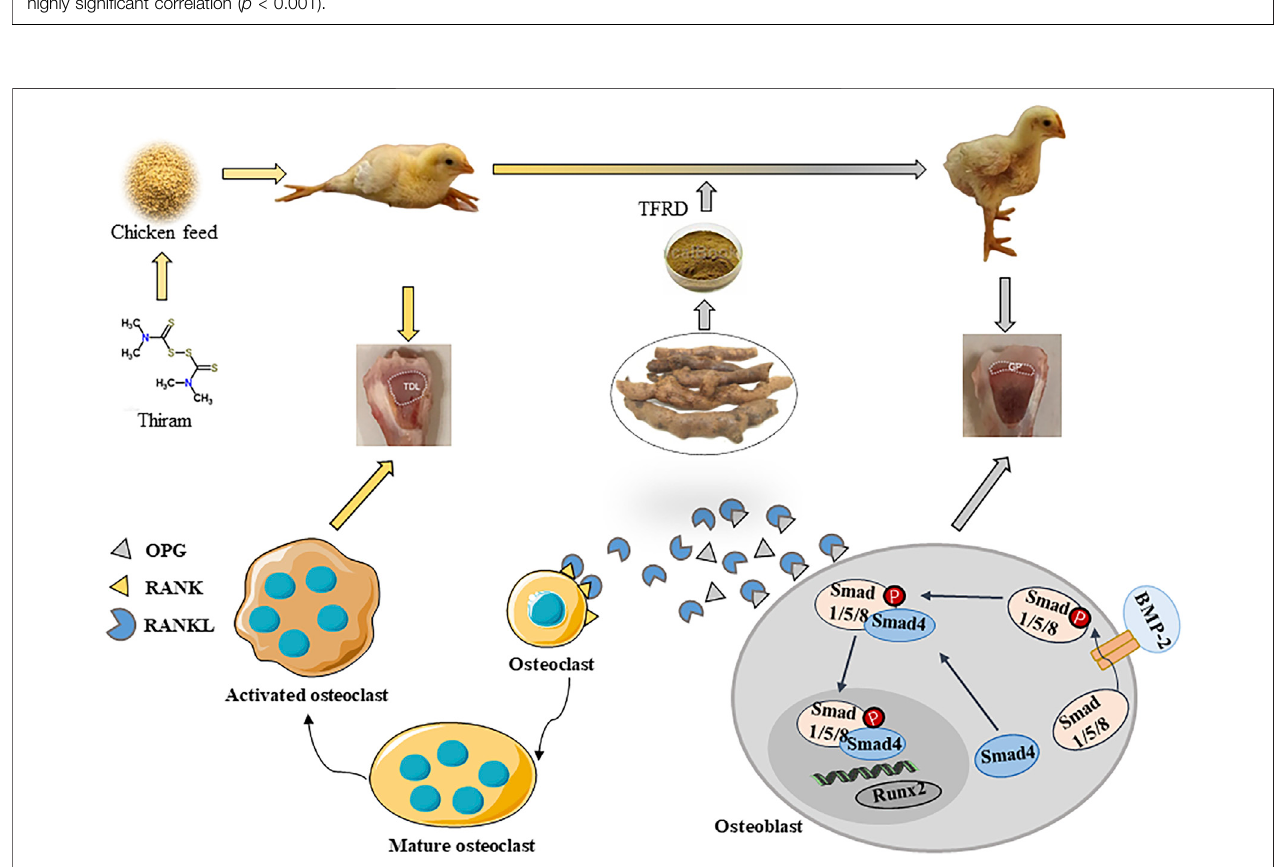
FIGURE 7 | The schematic diagram of the protective mechanism of TFRD on TD broilers by regulating the OPG/RANKL expression.